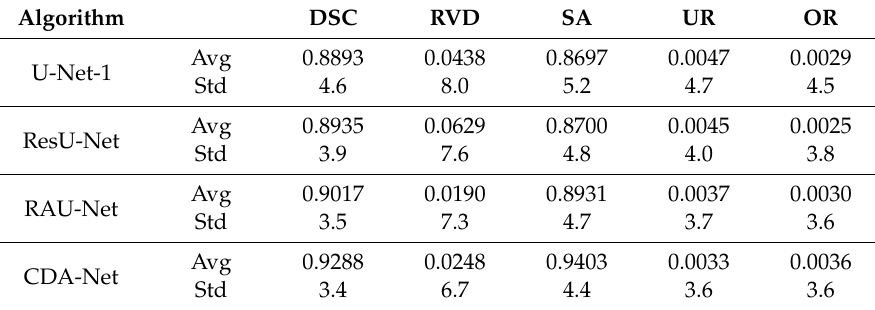
Table 3. Evaluation results of four algorithms on PROMISE12.